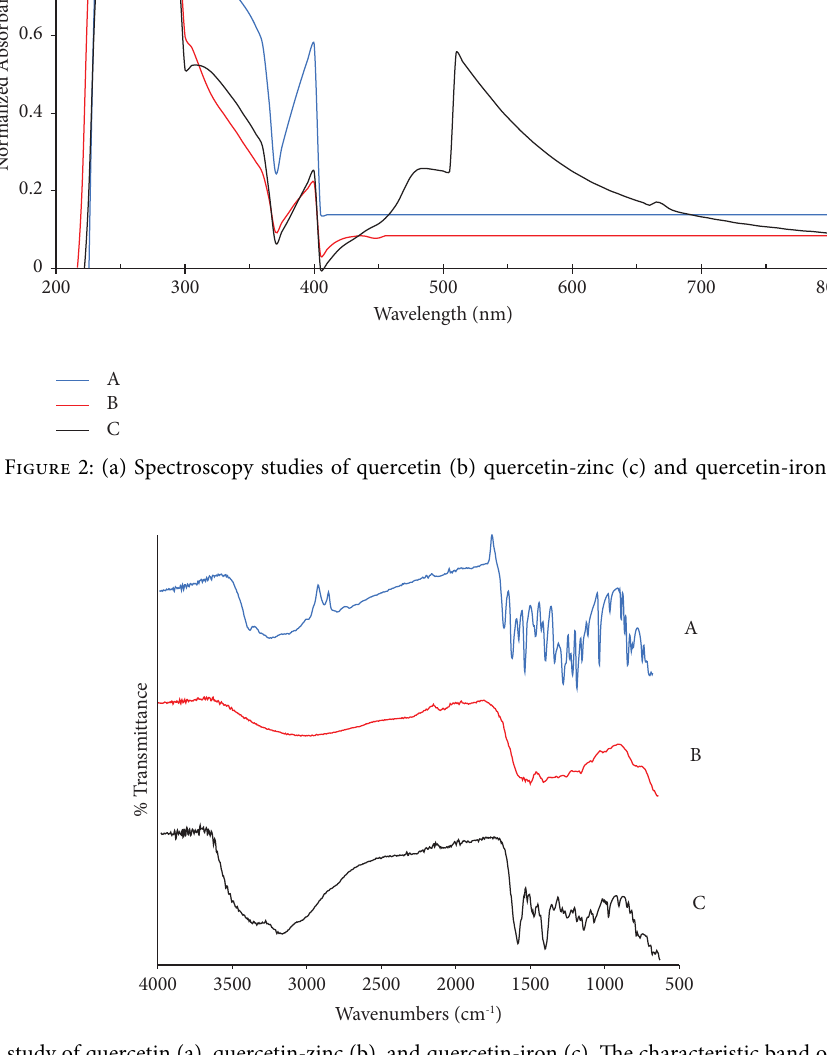
Table 1: Efect of quercetin and its complexes on the body weight, relative kidney and liver weight of sodium arsenite-induced alterations in rats.